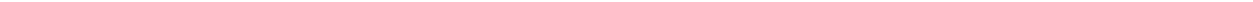
FIGURE 2 | KDM3C demethylates H3K9me2 on the MyoD distal regulatory region (DRR). When KDM3C is depleted, MyoD transcription is inhibited and H3K9me2 marks are accumulated on DRR region (Luo et al., 2017). (E) During skeletal muscle differentiation, KDM4A/B remove both H3K9me2 and H3K9me3 marks on MyoD andMyoGpromoterstoensuretheirtranscription.Thus,inhibitionofKDM4A/BresultsintoinhibitionofMyoDandMyoGtranscriptionthusskeletalmuscledifferentiation impairment(Verrieretal.,2011;Choietal.,2015;Zhuetal.,2021). (F) SIX4transcriptionalfactorrecruitsUTXonMyogeninandCkmregulatoryregions,here,thehistone chaperoneSPT6tethersUTXtotheelongatedRNApolII,inordertopromoteH3K27me3demethylationallalongthegenesequences.Conversely,absenceofUTXleads to accumulation of H3K27me3 marks thus resulting in transcription repression (Seenundun et al., 2010; Wang et al., 2013; Chakroun et al., 2015).